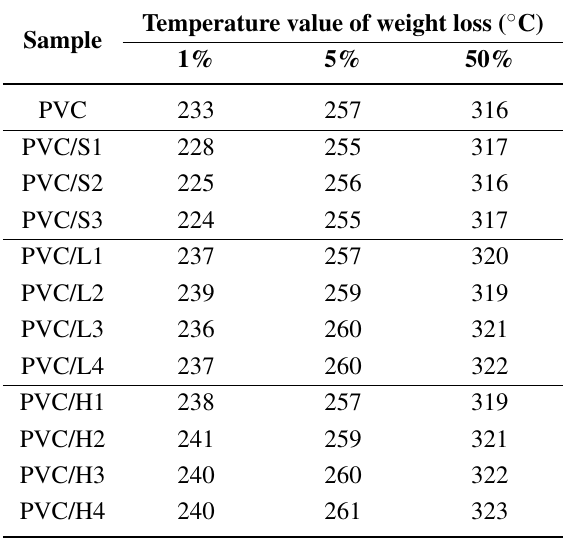
Table 3. The thermal stability properties of the tested